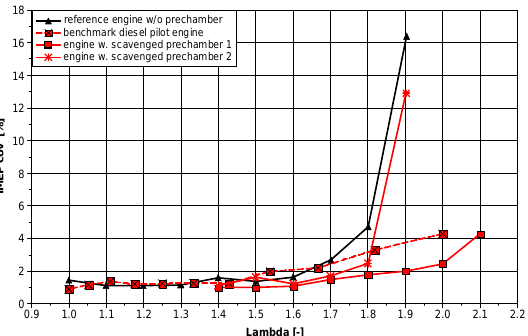
Fig. 14. Cyclic variations for the operating point 1 (1400 rpm/50 Nm)